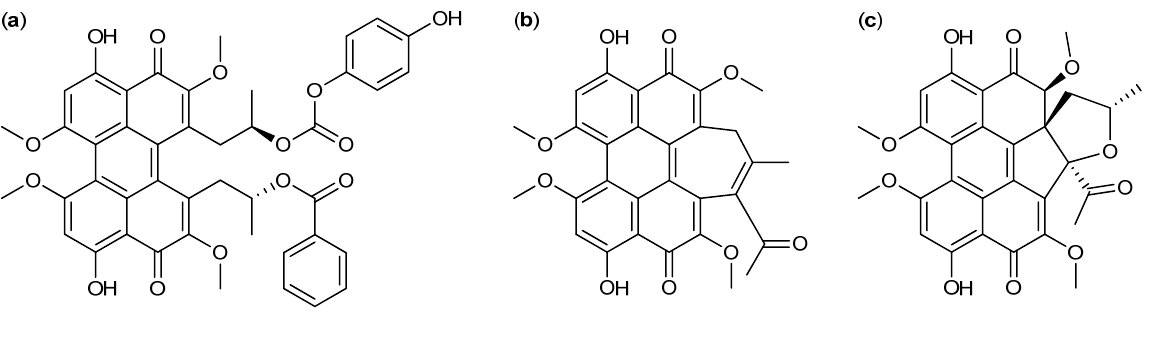
Figure 10. Perylenequinones: ( a ) Calphostin C, ( b ) Hypocrellin B and ( c ) Phaeosphaerin